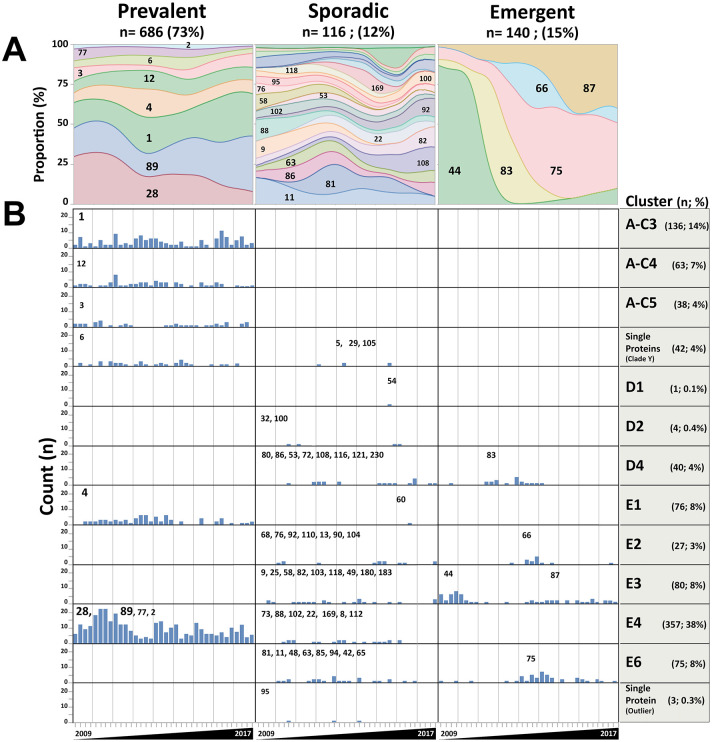
Dynamic profiles of GAS emm types and emm cluster-typing classification from 2009 to 2017.A) The densities of each of the 61 emm types were represented and were classified according to their dynamic profile observed during the study period. B) For each emm type, the number of isolates from 2009 to 2017 was reported by quarter. They were organised according to their dynamic profile (column) and their corresponding cluster (row, indicated at the right side). Emm types were indicated in the corresponding box. Emm types 6, 5, 29 and 105 were grouped within a single row named “Single protein (clade Y)”, and corresponded to four individual clusters, M6, M5, M29 and M105 respectively. “Prevalent” emm types (emm1, 12, 3, 6, 4 28, 89, 77 and 2) belonged to the clusters A-C3 to 5, M6, E1, and E4. “Emergent” emm types (emm44, 66, 82, 75, and 87) belonged to clusters D4, E2 and E3 that were different from those of the “Prevalent” emm types.